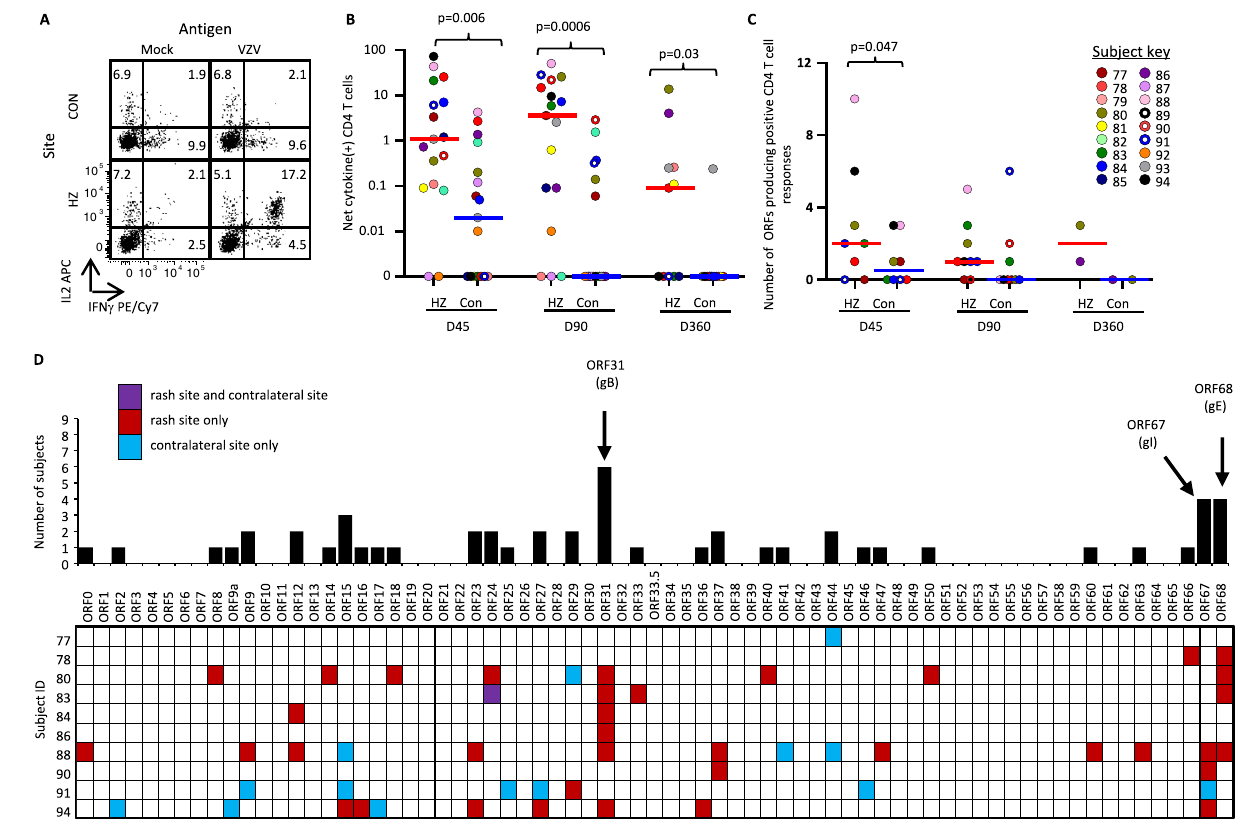
Fig. 3 | VZV-speci fi c skin-CD4 T cells. A Example of VZV-speci fi c CD4 T cell detection by ICS for IFN- γ and/or IL-2 in skin T cell lines (TCL) exposed to UV- inactivated VZV (UV-VZV) or mock antigen, showing VZV-speci fi c CD4 T cells localized to HZ skin. Day 90 sample from subject 78. B Net frequency of VZV- speci fi cCD4TcellsinHZ-TCLandCON-TCLbyICSforIFN- γ and/orIL-2(day45and day90 n =17;day360, n =10).Linerepresentsmedian.Unadjusted2-sided p values frommultipleWilcoxonteststocompareHZskinsiteandCONskinsitedatawithin time points are shown. C Breadth of T cell proliferative responses as measured by number of reactive VZV ORFs in skin-TCL from days 45 ( n =8), 90 ( n =9), and 360 ( n =2). Skin-TCL pairswerescreenedif either the HZ-TCL orCON-TCL had >3% net